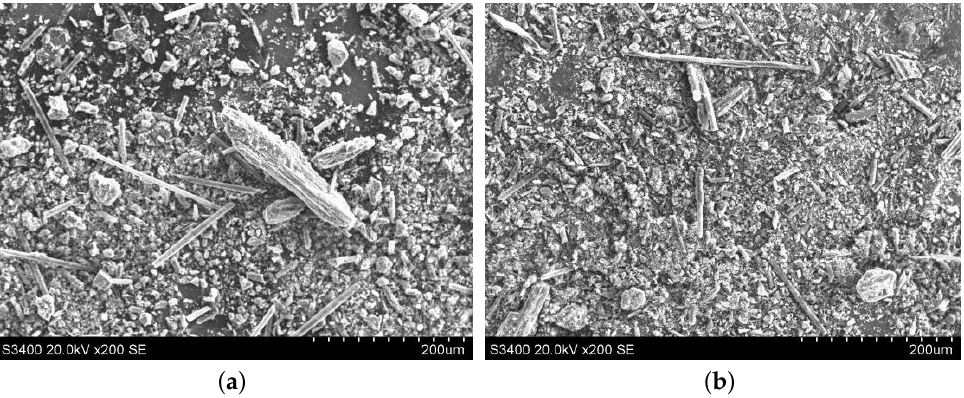
Figure 18. Morphologies comparison when a p is 0.2 mm. ( a ) is ordinary cutting and ( b ) is ultrasound- assisted cutting.